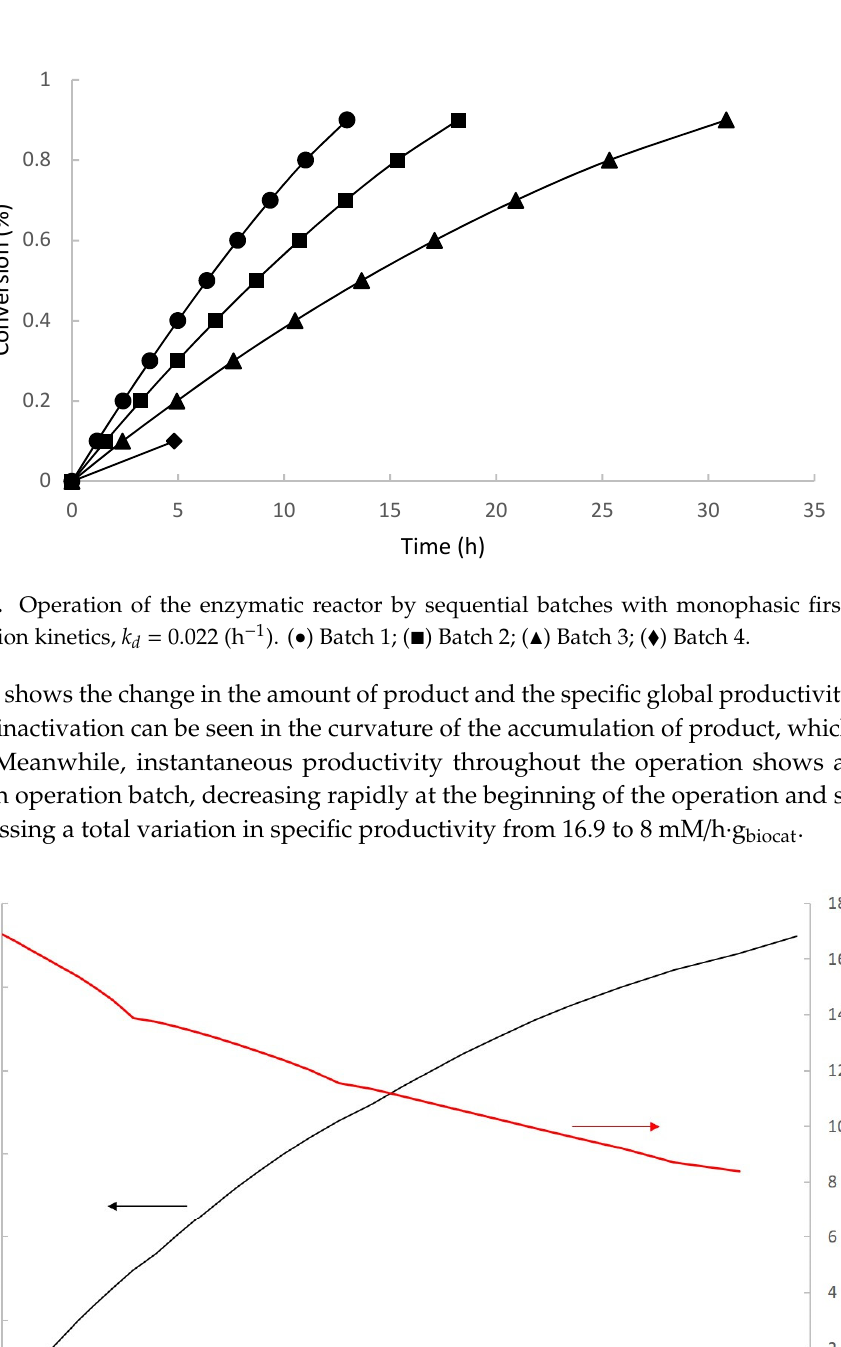
Figure 5. Specific activity during the operation of sequential enzymatic reactors with monophasic first-order inactivation kinetics, k d = 0.02 h –1 . By incorporating interspersed enzymatic reactivation stages, it can be seen that the number of batches increases from four to six-and-a-half (Figure 6). Regarding the amount of product in Figure 7, it can be seen that the accumulation of product increases with respect to the process without reactivation; however, in terms of productivity, it decreases with respect to the inactivation process from 8 to 4 mM/h·g biocat due to the incorporation of the reactivation time.